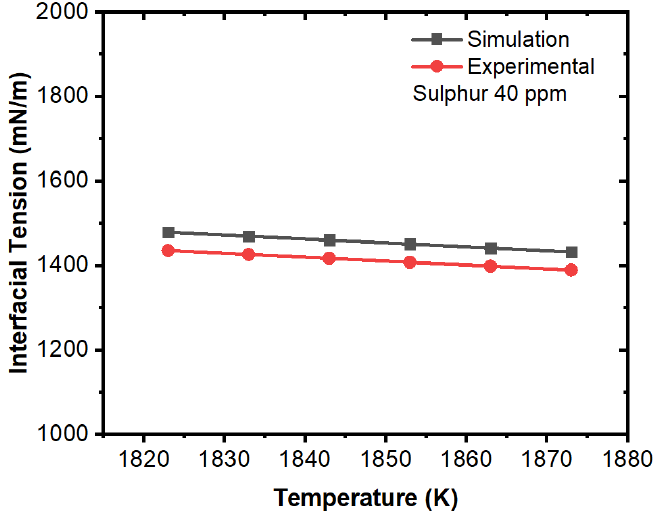
Figure 16. Comparison of experimental and simulation results of interfacial tension with respect to temperature (sulfur: 40 ppm, experimental work by Jeong et al.